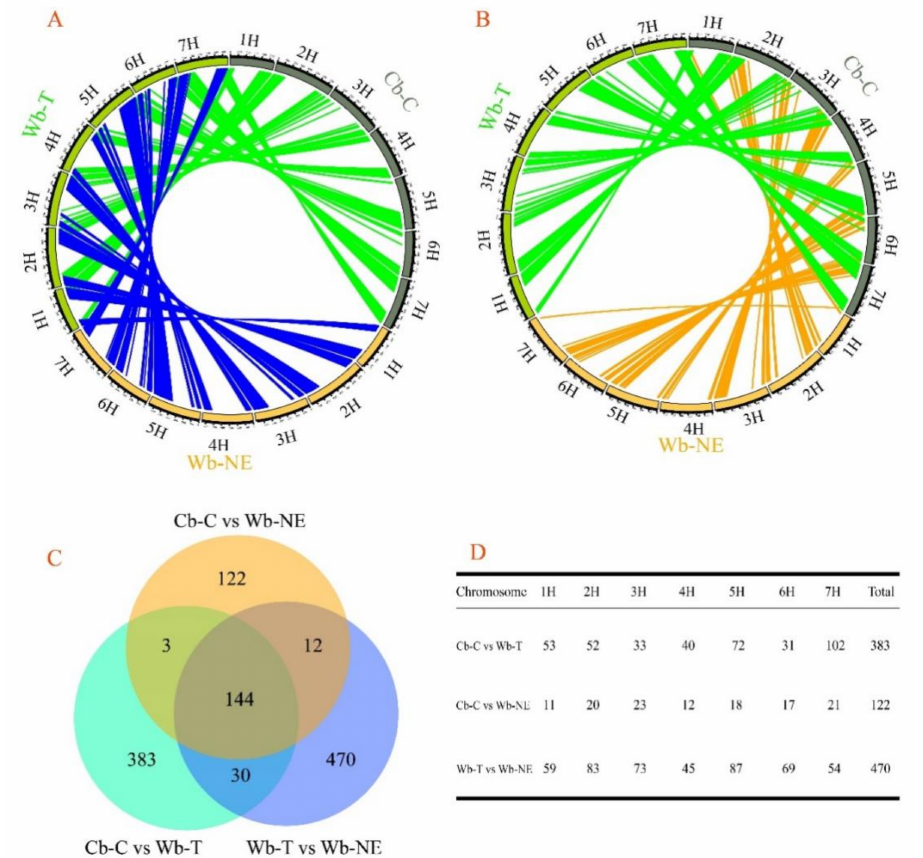
Figure 2. Genomic similarity between three groups of barley accessions. Wb-NE, wild barley from the Near East Fertile Crescent. Wb-T, wild barley from the Tibetan Plateau. Cb-C, cultivated barley from China. ( A ) Circos diagram with lines shows genomic similarity regions between Wb-T and Wb-NE (blue lines) and between Wb-T and Cb-C (green lines). The similar regions were connected with lines and each line represented one unique window (150 kb) of the genome with the highest similarity between two populations. ( B ) Circos diagram with lines showing genomic similarity regions between Cb-C and Wb-NE (orange lines) and between Wb-T and Cb-C (green line). The similar regions are connected with lines and each line represents one unique window (150 kb) of the genome with the highest similarity between two populations. The green line was consistent with the green line of sub-figure ( A ). ( C ) Venn diagram exhibiting the numbers of genomic similarity regions among the three groups. ( D ) The numbers of unique genomic similarity regions on seven